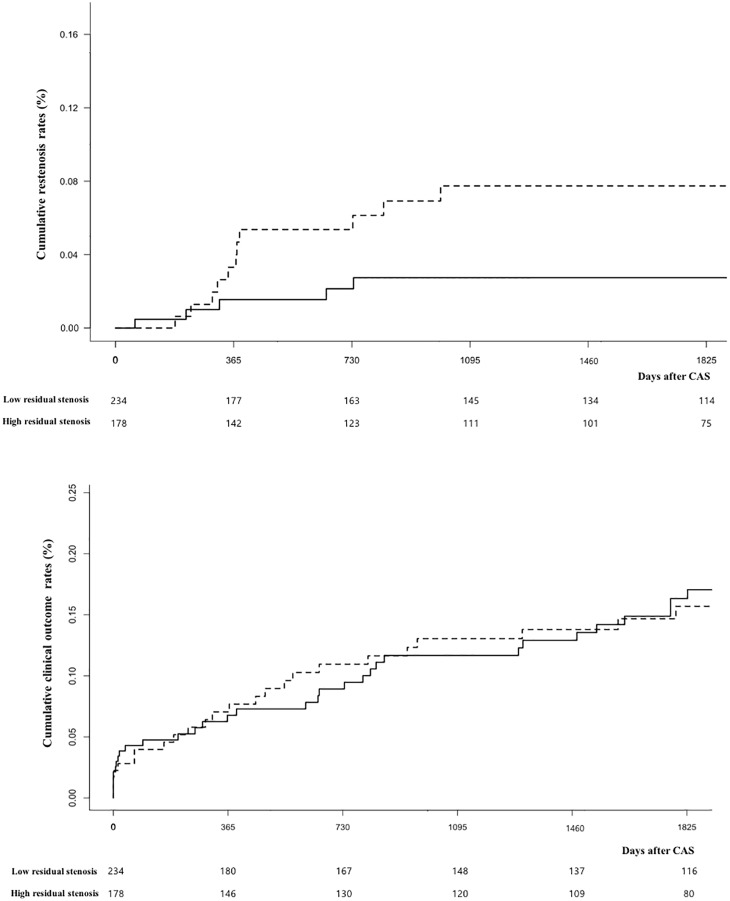
Kaplan-Meier survival curves of residual stenosis for hazards of restenosis (upper) and clinical outcome (lower).The P values determined by log-rank test were 0.047 (upper) and 0.86 (lower), respectively. The solid line indicates low residual stenosis, and the dotted line indicates high residual stenosis.